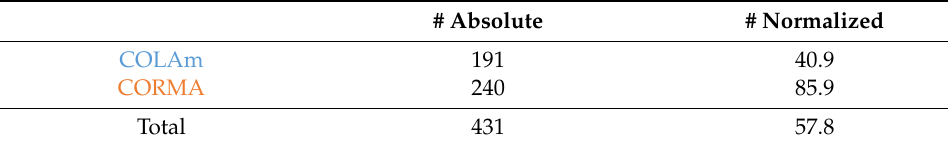
Table 2. Normalized frequency of intensifiers per corpus.